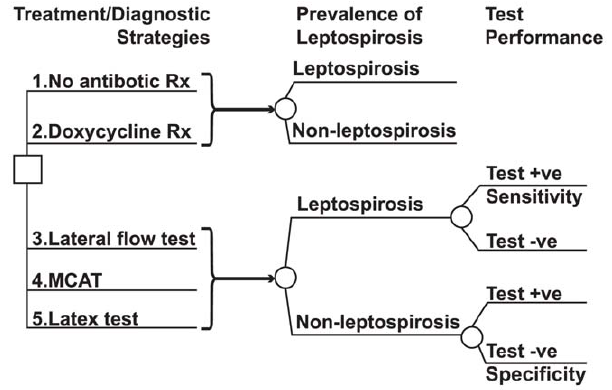
Figure 1. The decision model showing each of the treatments and diagnostic options (first five branches). The square at the far left of the diagram represents a decision node, with each branch representing the clinical management choices. The brackets indicate that patients who received each of the strategies proceeded to the subtree to the right. The circles at the start of each subsequent branching indicate chance nodes representing the uncertainty sur- rounding possible subsequent outcomes indicated in the branches to the right. This diagram shows the portion of the decision tree modeling the management strategies, the prevalence of leptospirosis, and diagnostic test performance (sensitivity and specificity).